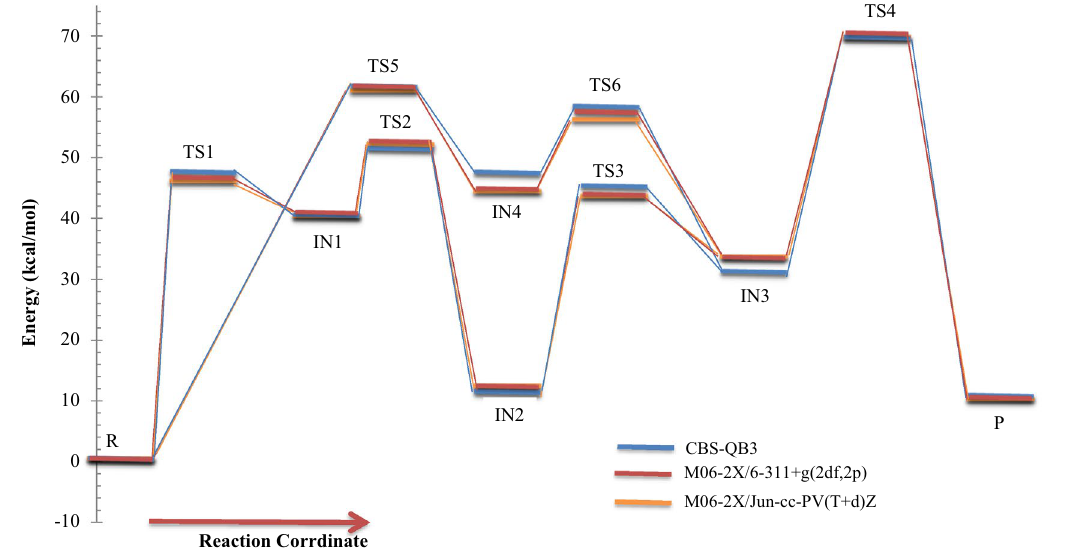
Figure 8. Energy diagram for 3-hydroxythiophen-2(5H)-one unimolecular reaction computed at the CBS-QB3, M06-2X/Jun-cc-pV(T+d)Z, and M06-2X/6-311+g(2df,2p) levels.